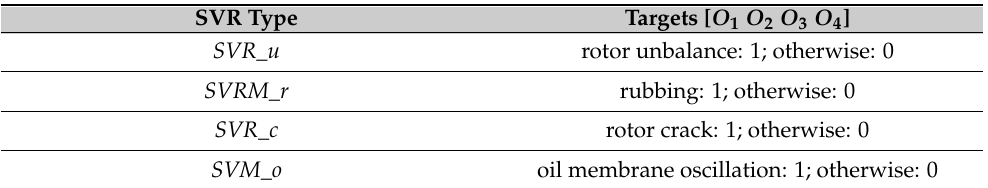
Table 2. The Targets of each SVR in the Training Set.